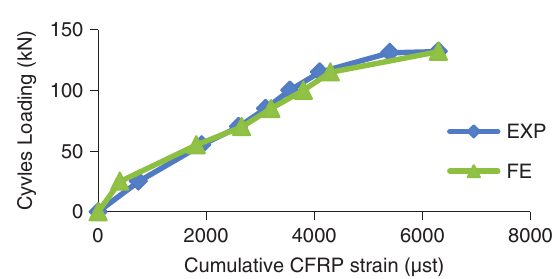
Fig. 15. Load against the cumulative CFRP strain for the post- repair phase of the beam